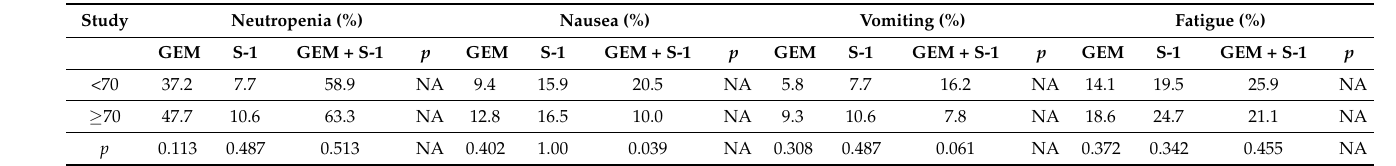
Table 6. Subgroup analysis by age of grade three and four adverse events for neutropenia, nausea, vomiting, and fatigue in Imaoka et al., 2016